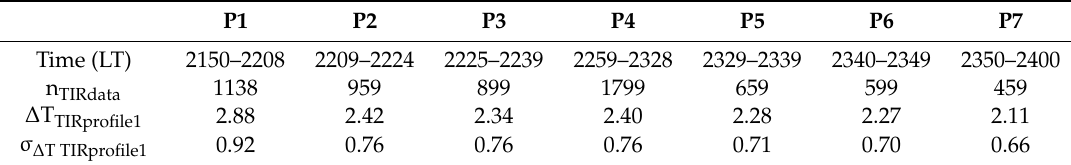
Table 1. Attributes of flow characteristic periods P1–P7: Mean value of vertical surface temperature difference of TIR profile 1 = ∆ T TIRprofile1 , mean value of standard deviation of vertical surface temperature difference of TIR profile 1 = σ ∆ T TIRprofile1. P1 P2